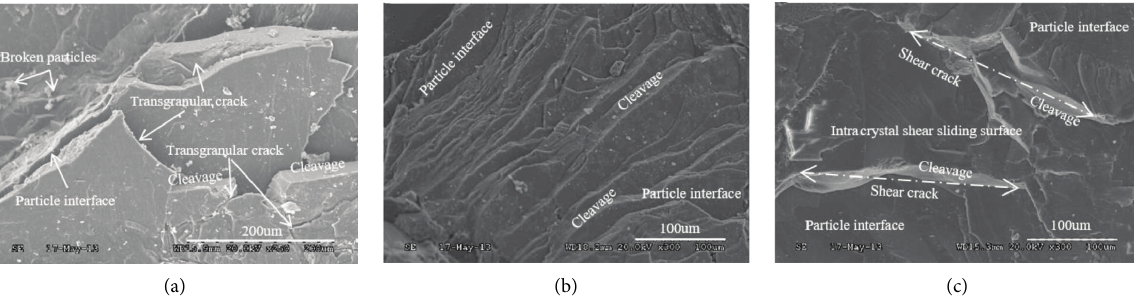
Figure 4: Main microfeatures of feldspar. (a, b) Plate or layered rupture fractures in granite samples. (c) Two groups of cleavage. Rupture fractures in granite samples.